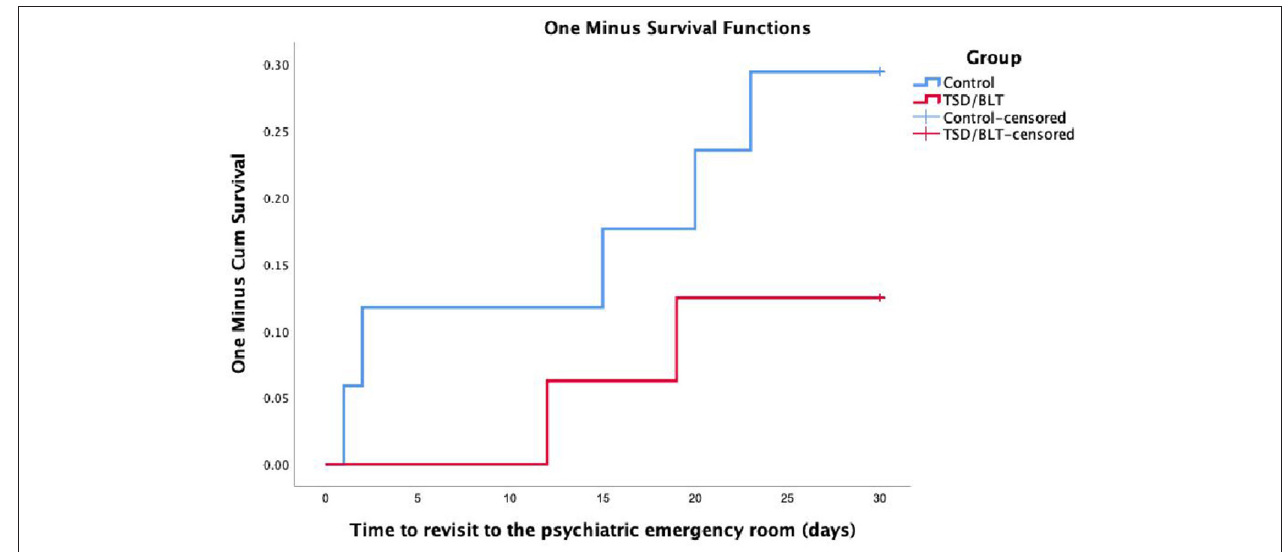
FIGURE 3 | Kaplan-Meier survival curve for time to psychiatric emergency room revisit.